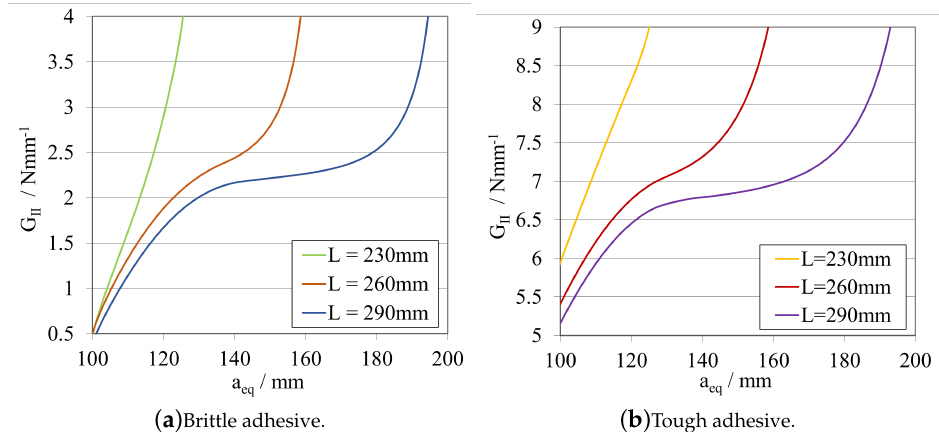
Figure 11. R-curves related to the L ELS